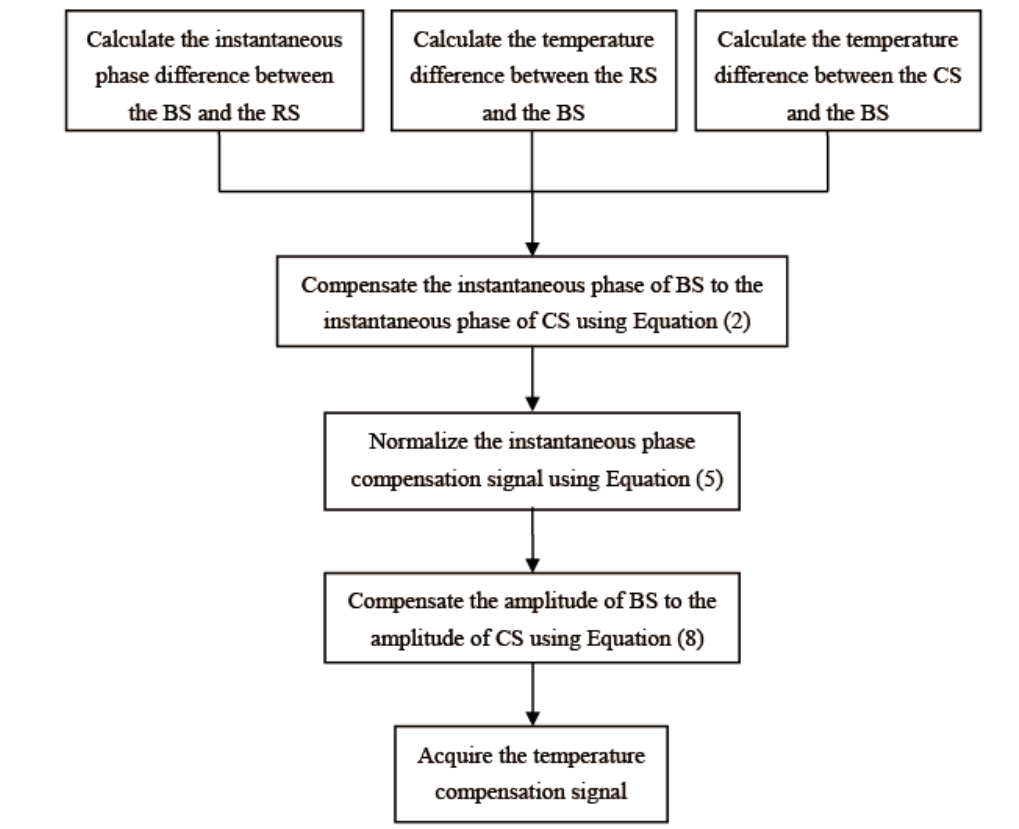
Figure 1. The flowchart of the proposed temperature compensation method. BS: baseline signal, RS: reference signal, CS: current signal.